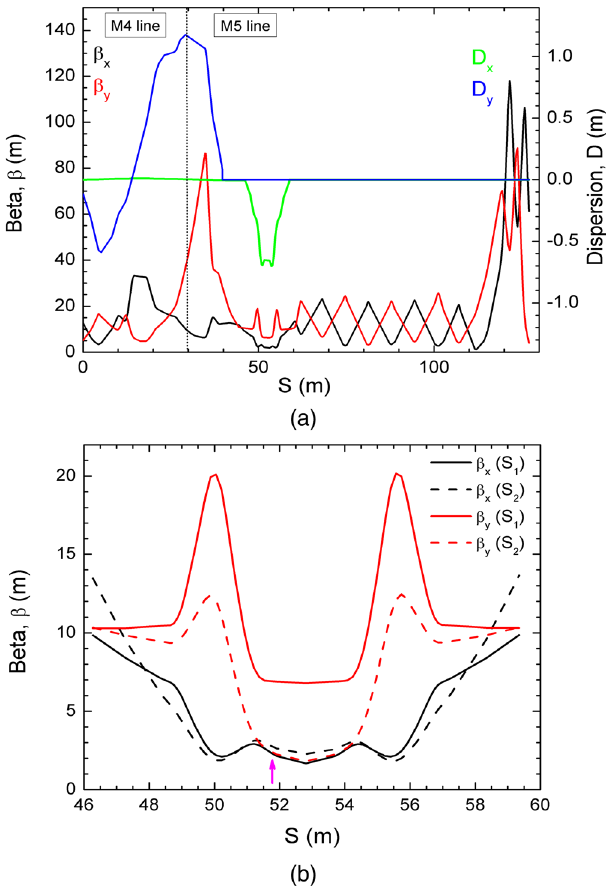
FIG. 3. (a) Baseline design optics functions for the M4 and M5 lines where the M5 ends at the entrance of the muon storage ring. The M5 starts at S ≈ 30 . 0 m and a 27.1° horizontal bend string begins at S ≈ 46 . 0 m that provides proper entry position into the ring. (b) Closeup along the ∼ 13 m long M5 horizontal bend string. The solid curves show the optical functions of the baseline design which we call solution S 1 . The dashed curves show an alternative scheme that delivers the same number of muons as the baseline but with a suppressed vertical beta function along the bend area and therefore is expected to reduce the scattering effect. We call this solution S 2 . Note that both solutions have almost equivalent dispersion along the